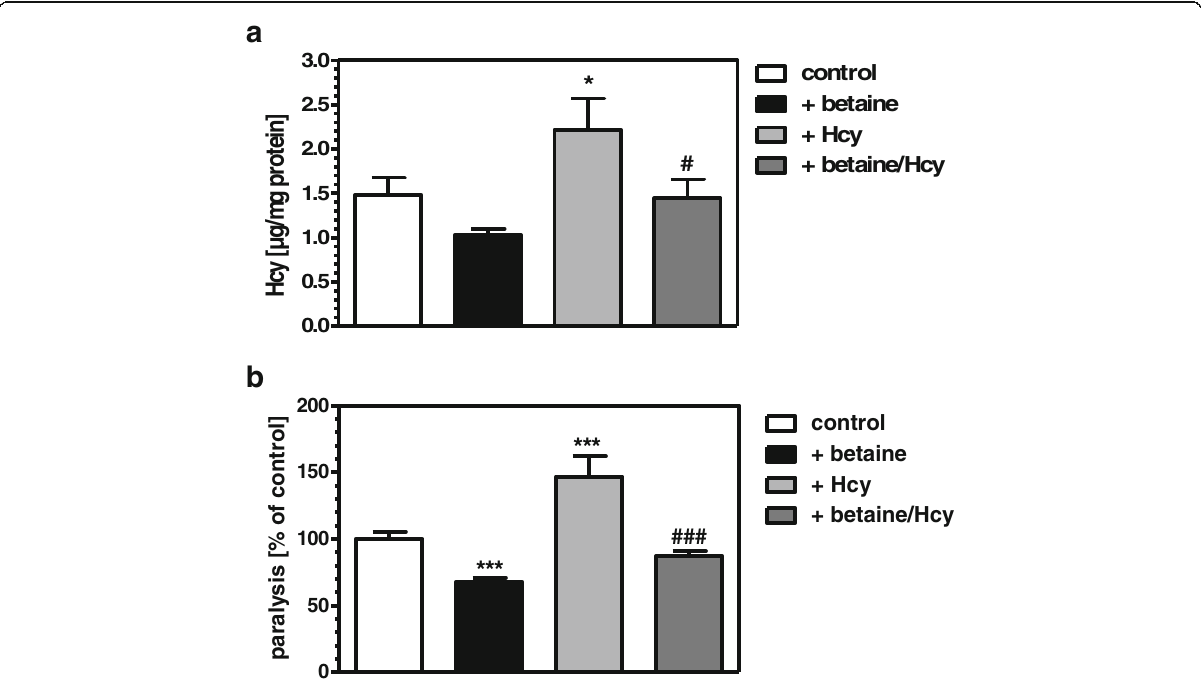
Fig. 2 Betaine reduces Hcy level and paralysis rate in the absence and presence of exogenous Hcy. Hcy level was determined either in control nematodes or those treated with 1 mM Hcy. Moreover, in an additional experiment, both groups were exposed to 100 μ M betaine also ( a ). Paralysis was determined under identical conditions as described for Hcy measurements ( b ). * p <0.05, *** p <0.001 versus the control; ### p <0.001